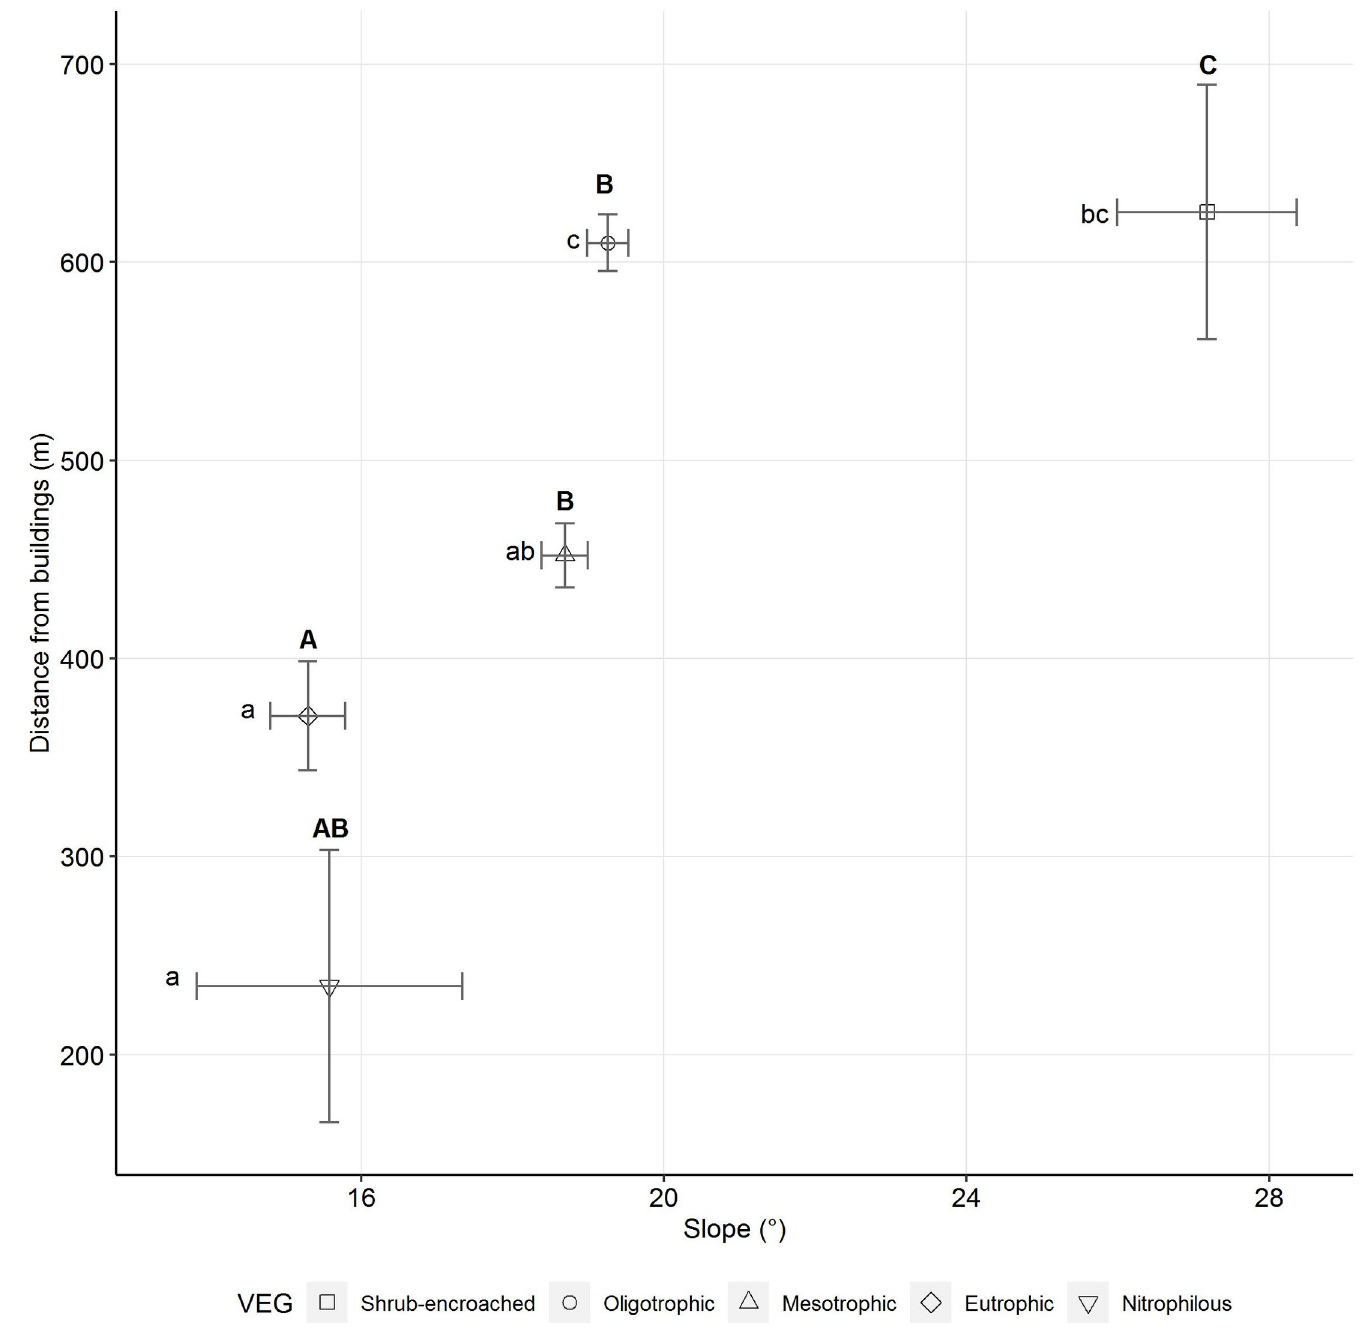
Fig 5. Mean values of slope and distance from buildings for each Vegetation Ecological Group at regional-scale study. Horizontal and vertical error bars represent the standard error of the mean for the slope and the distance from buildings, respectively. Capital and lower-case letters indicate significant differences according to Tukey’s post-hoc test with Bonferroni-adjusted p-values for the slope and the distance from buildings, respectively. curves of the GAM, the steeper and the farther from buildings were, the lower the number of GPS locations was. Considering that site-use intensity was measured by means of GPS collars, which are considered one of the most accurate tools for studying livestock spatial patterns and